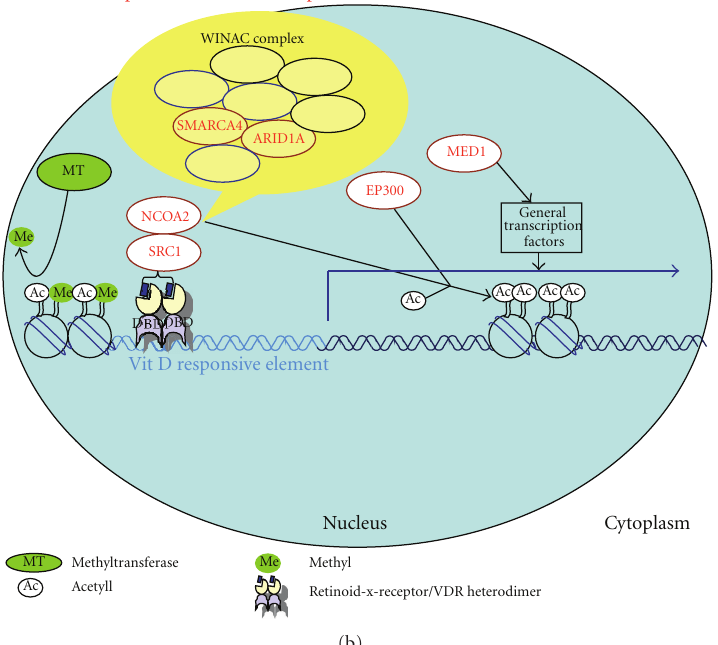
Figure 5: AR-interacting proteins are WINAC complex components and transcriptional activators of VDR-mediated gene expression. Presented is a simplified version of the BIOCARTA pathway “control of gene expression by Vitamin D receptor (VDR)” illustrating how AR and VDR may compete for shared coregulators. (a) In AR copurifications from proliferating P17 cells (33 ◦ C), the transcriptional activators EP300, SRC1 ∗ , and 5 proteins from the ATP, dependent chromatin remodelling complex WINAC: SMARCA4, ARID1A, ARID1B, SMARCC1, and SMARCD1 were identified. Under proliferating conditions, AR would therefore compete with VDR for 5 WINAC components and for 2 transcriptional activators. (b) In copurifications from nonproliferating P17 cells (37 ◦ C) only 2 known AR-interacting proteins identified were components from the WINAC complex: SMARCA4 and ARID1A. However, 4 proteins identified: EP300, NCOA2, MED1, and SRC1 ∗ act as transcriptional activators in VDR, mediated gene expression. Under nonproliferating conditions, AR would therefore compete with VDR for 2 WINAC components and 4 transcriptional activators. ∗ SRC1 is a general transcription activator for steroid receptors and also component of this pathway. SRC1 was not identified by mass spectrometry, but AR-associated in Western blots of FLAG-purifications from nuclear extracts of proliferating and nonproliferating P17 cells (Figures 4 and